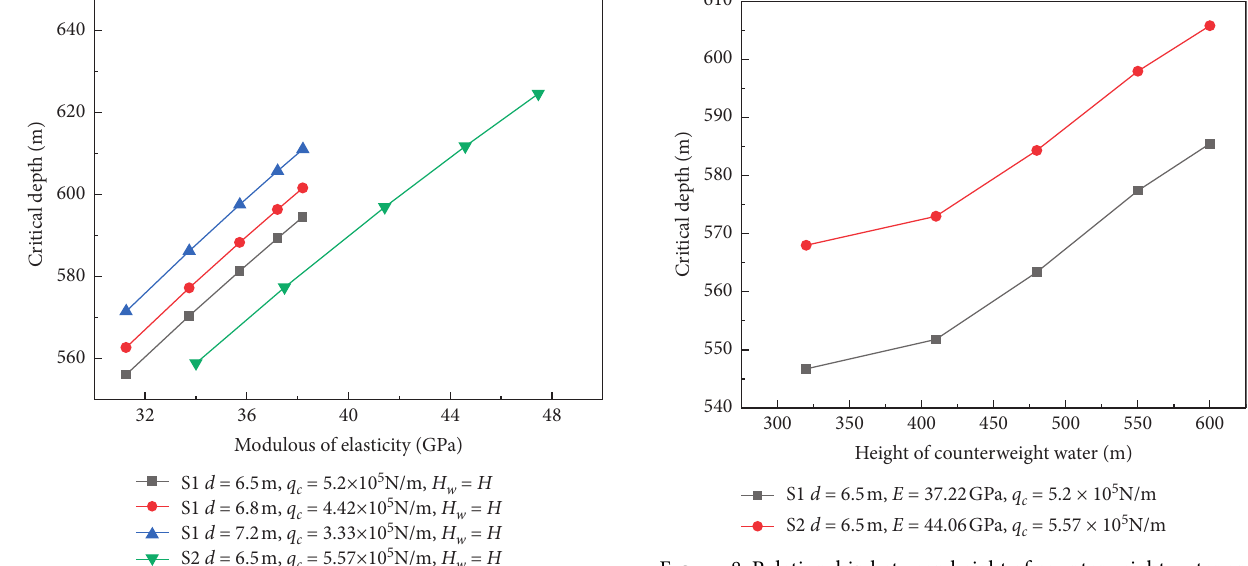
Figure 8: Relationship between height of counterweight water and critical depth.